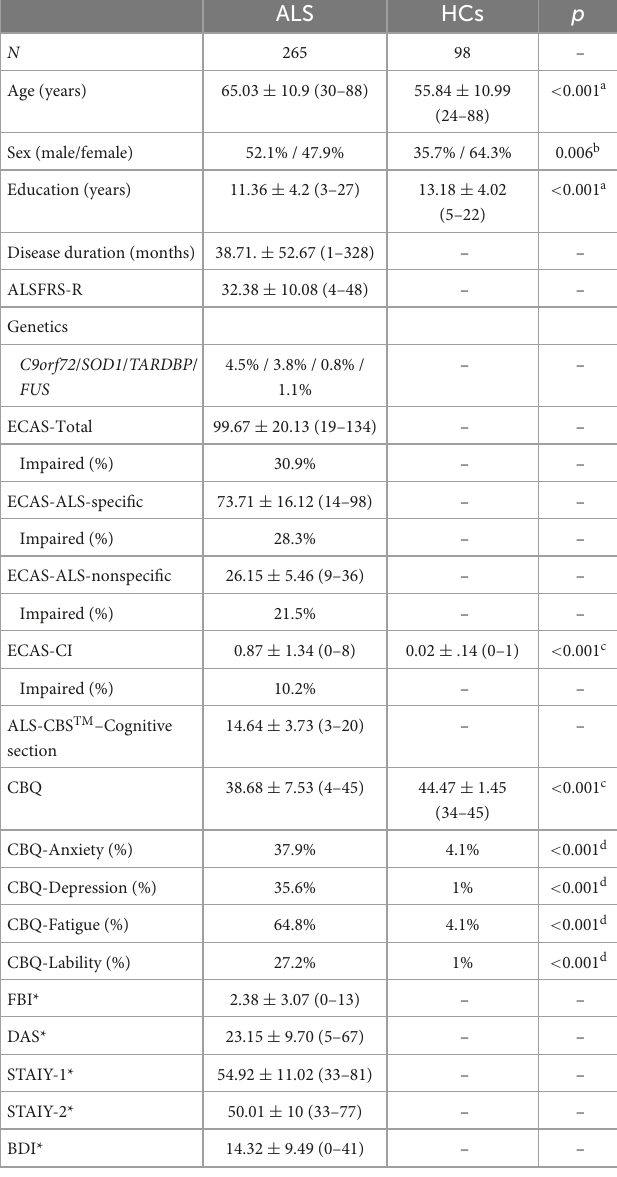
TABLE 1 Participants’ background and neuropsychological